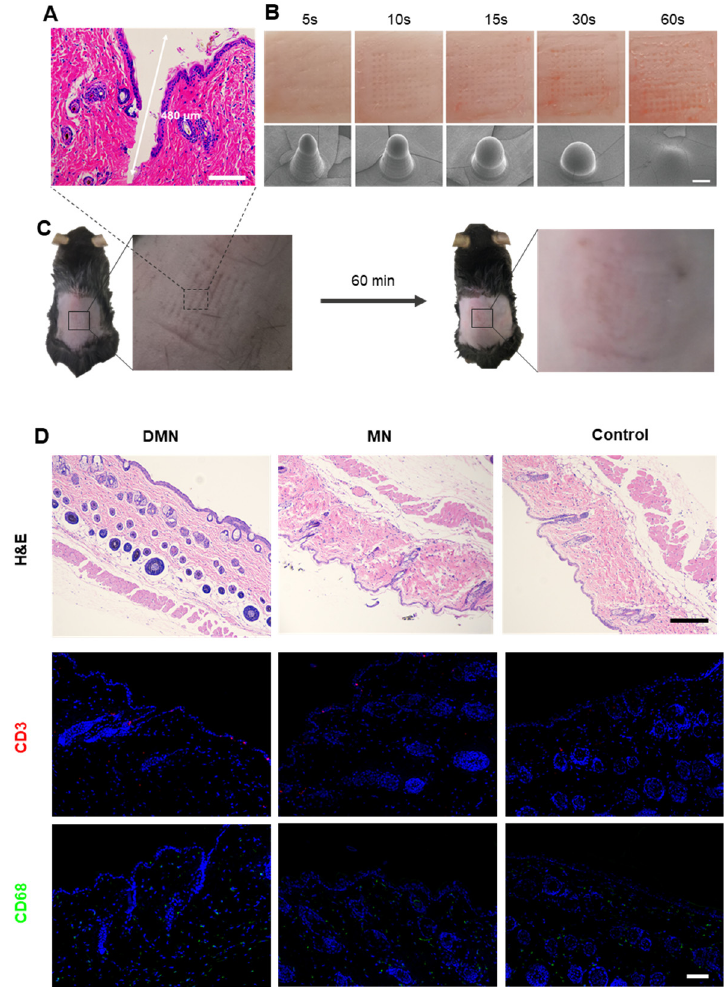
Figure 4. In vitro and in vivo administration of MNs. ( A ) H&E staining image of the mouse dorsal skin after MN penetration. Scale bar: 100 μ m. ( B ) Photographs of porcine cadaver skin and SEM images of MNs after penetration at different time points. Scale bar: 100 μ m. ( C ) Photographs of mice after penetration and at 60 min postinsertion with removal of MNs. ( D ) H&E and immunofluores- cence staining of treated mouse skin at day 10. CD3 (marker of lymphocyte infiltration) is shown in red, CD68 (marker of macrophages) is shown in green, and cell nuclei (DAPI) are shown in blue. Scale bar: 50 μ m.